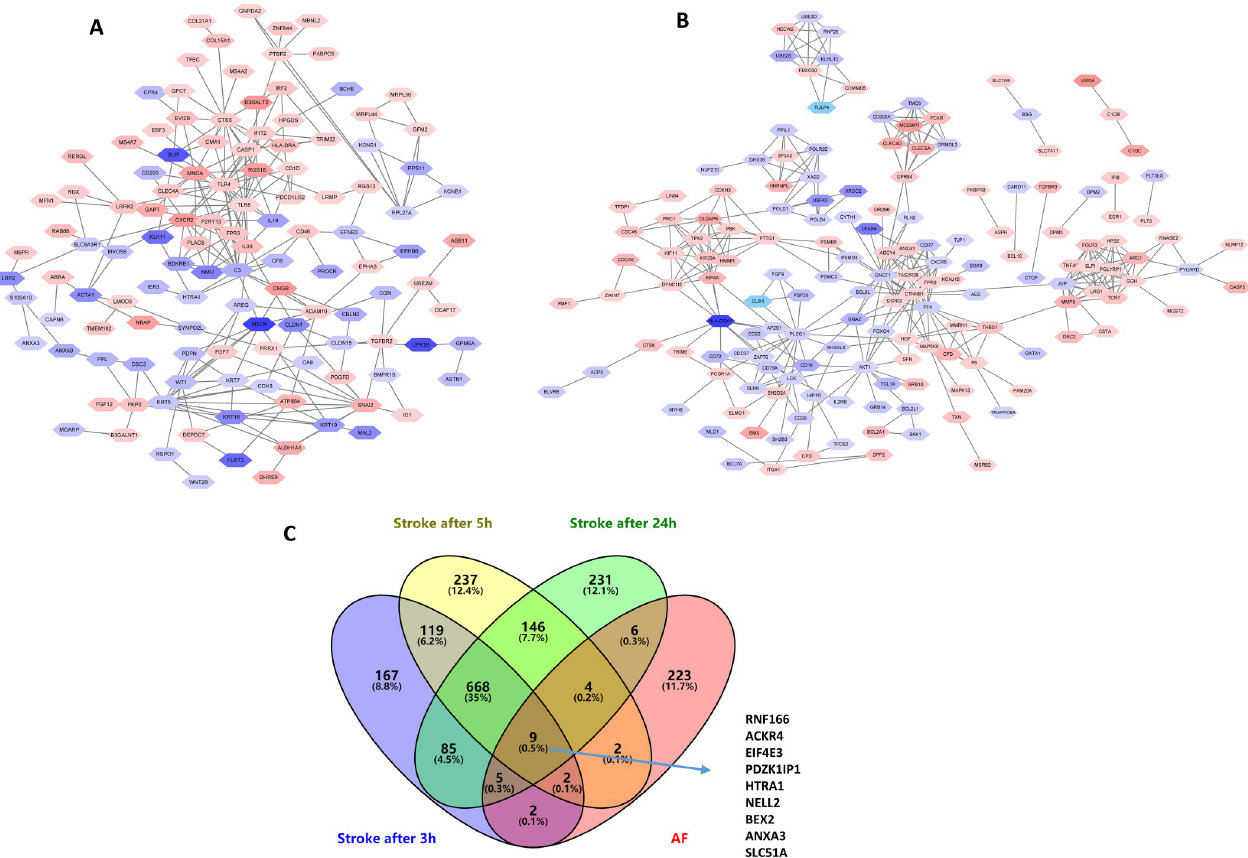
Fig 6. PPI network of AF-related DEGs (A), PPI network of Stroke-related DEGs (B), and Venn diagrams of AF-related stroke genes (C) were presented. Red, greater degree. blue, lesser degree.